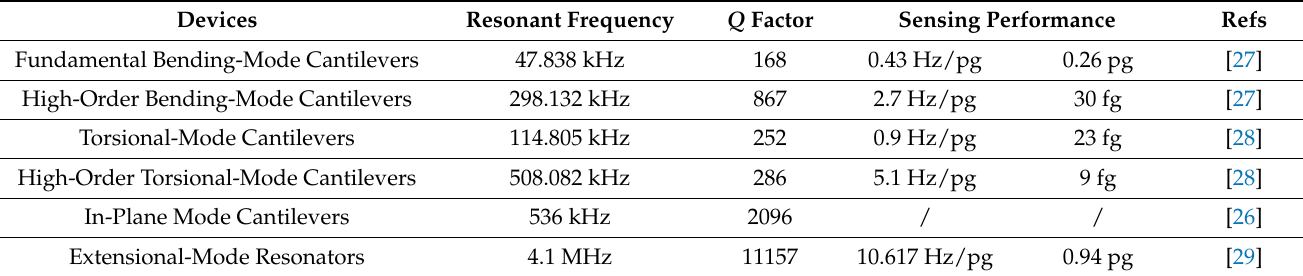
Table 1. Performance of typical integrated resonant gravimetric sensors in air using different vibrational modes.